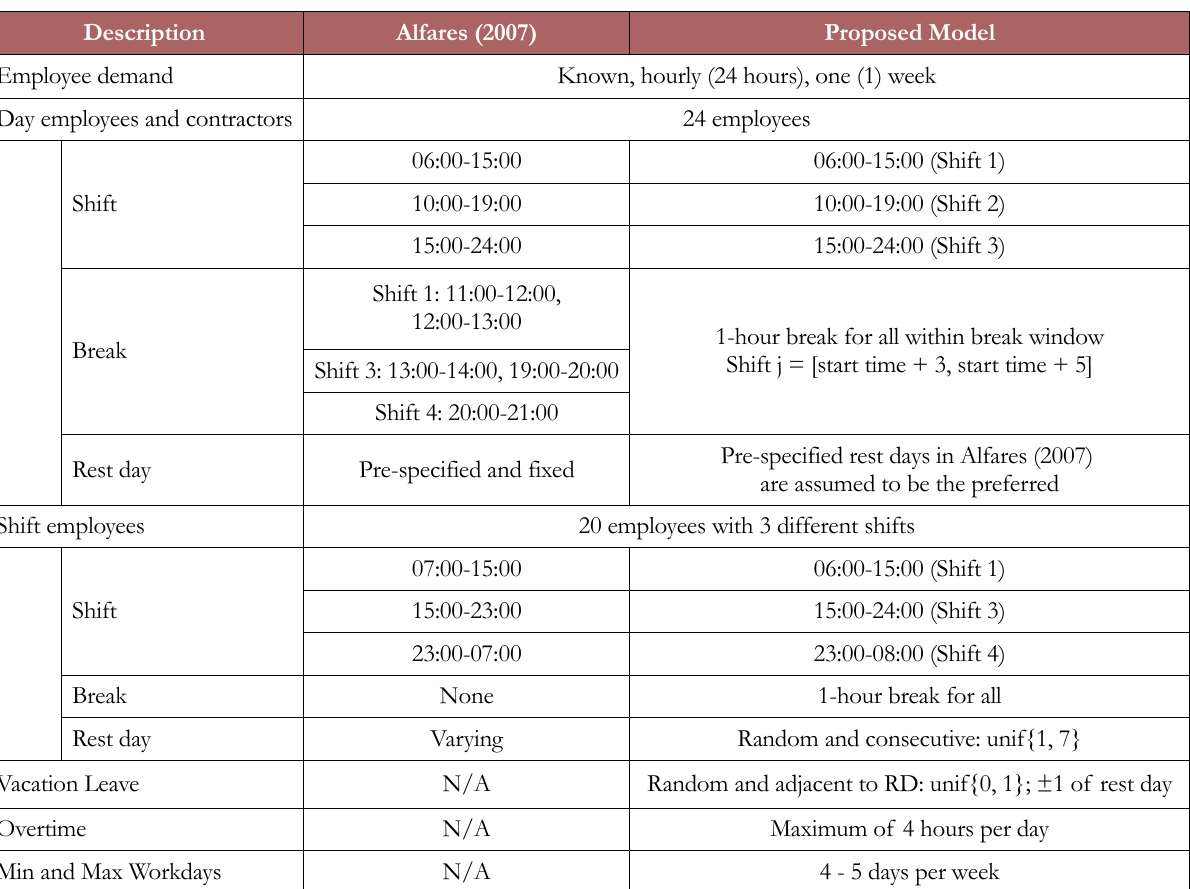
Table 5. Problem Summary of Alfares (2007) and the Proposed